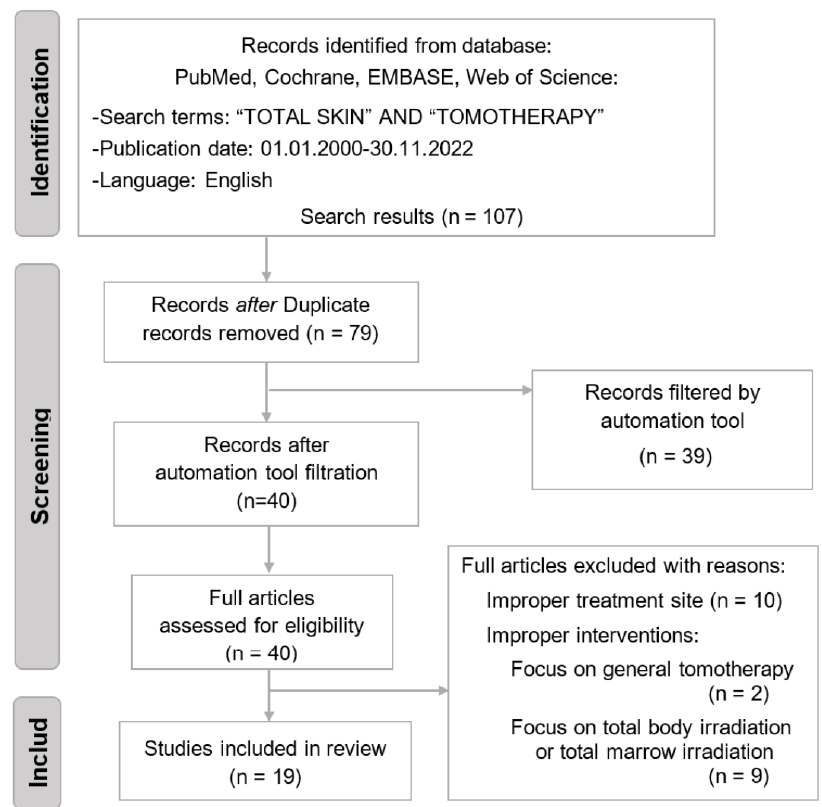
Figure 1. The PRISMA flow diagram for study inclusion.